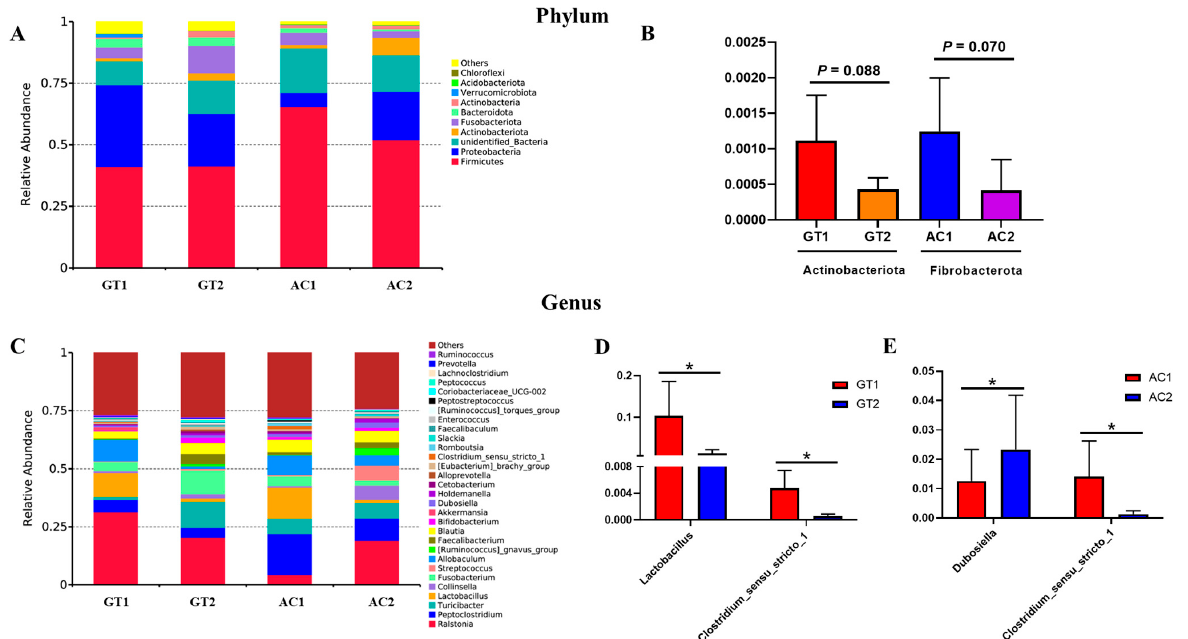
Figure 4. Abundance distribution and column chart of the fecal microbiota. Abundance distribution of the top 10 phyla in GT and AC groups ( A ); column chart in in GT and AC groups ( B ). Abundance distribution of the top 30 genera in GT and AC groups ( C ); column chart in GT ( D ) and AC groups ( E ). Values in ( A – D ) were analyzed by paired Student’s test and are presented as the means ± SE. GT1, before gradual transition, n = 6; GT2, after gradual transition, n = 6; AC1, before abrupt change, n = 7; AC2, after abrupt change, n = 7. * Significant difference between two groups (* p < 0.05).